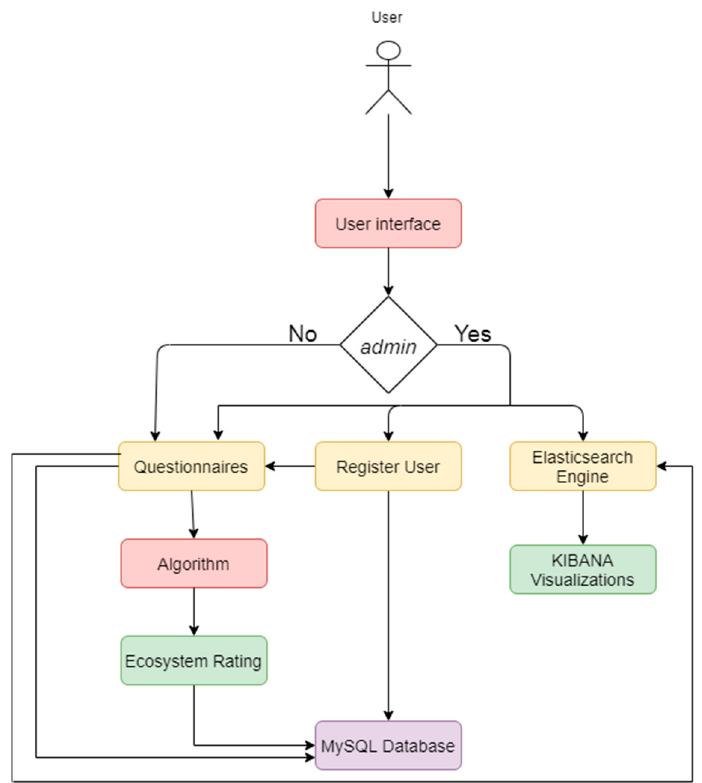
Figure 2. MAES platform programming architecture.